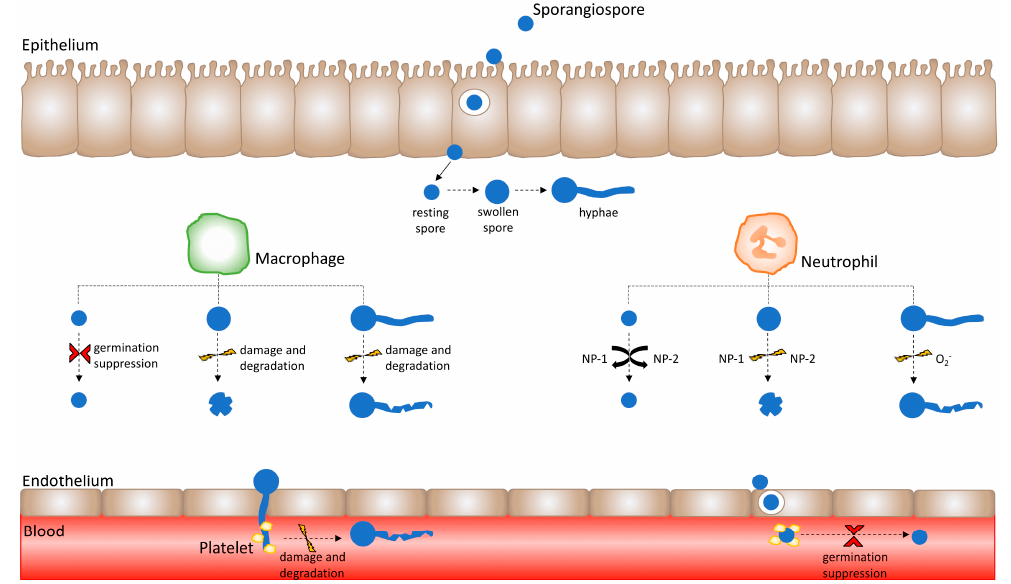
Figure 1. Healthy innate immune effector responses are influenced by the Mucorales spore developmental stage. Immune effector activity varies depending upon the developmental stage of the Mucorales sporangiospore. Following the successful crossing of the epithelium, spores encounter innate immune effectors such as macrophages and neutrophils. Macrophages suppress resting spore germination; however, they are unable to kill resting spores. Conversely, swollen Mucorales spores and hyphae are susceptible to damage and degradation by macrophages. Neutrophil cationic peptides do not exert activity against resting spores, but induce damage upon swollen spores. Moreover, neutrophil superoxide anion (O 2 − ) release causes damage to hyphae. Having crossed the endothelium layer by means of hyphal invasion and spore internalisation, Mucorales invade the vasculature and enter the bloodstream. Herein, Mucorales come into contact with platelets, whereby platelets adhere to Mucorales spores and hyphae to suppress